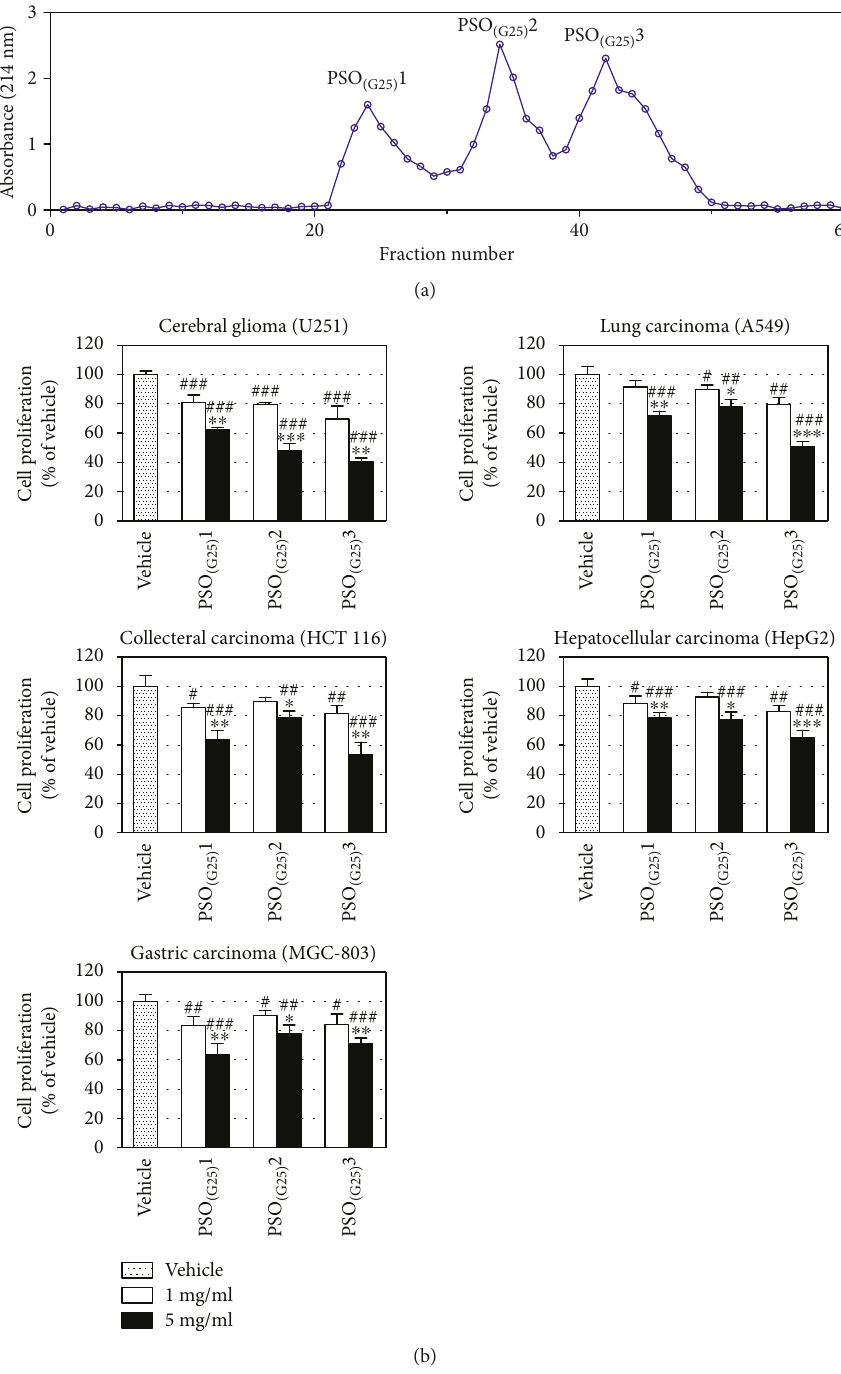
Figure 1: Puri fi cation of oligopeptides and their cytotoxicity screening. (a) Gel fi ltration chromatography on a Sephadex G-25 column, and 1, PSO 2, and PSO 3. (b) Anticancer e ff ect of three fractions on U251, A549, HCT116, HepG2, and there were three peaks, PSO (G25) (G25) (G25) MGC-803 with 1mg/ml or 5mg/ml for 24h, measured by the MTT assay. Percentages of cell proliferation were normalized by optical density values of the vehicle group (as 100%). Data are shown as means ± SD ( n = 5 ). ∗ denotes P < 0 05 , ∗∗ denotes P < 0 01 , and ∗∗ ∗ denotes P < 0 001 ; comparisons were performed between groups of 1 mg/ml and 5mg/ml of every fraction. # denotes P < 0 05 , ## denotes P < 0 01 , and ### denotes P < 0 001 ; comparisons were performed against the vehicle